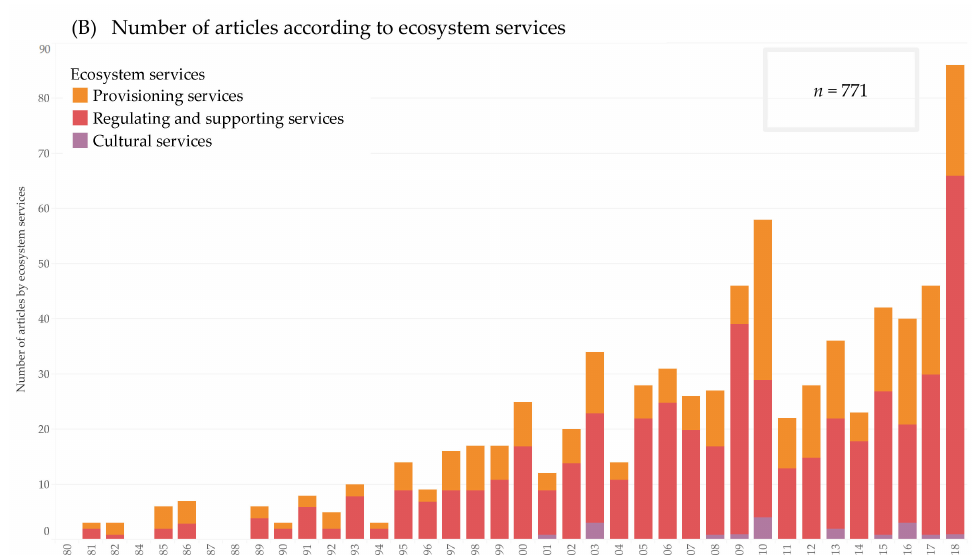
Figure 2. Distribution of the published articles on agroforestry practices and ecosystem services. ( A ) shows the number of publications related to agroforestry practices by year and ( B ) shows the number of articles related to ecosystem services by year.